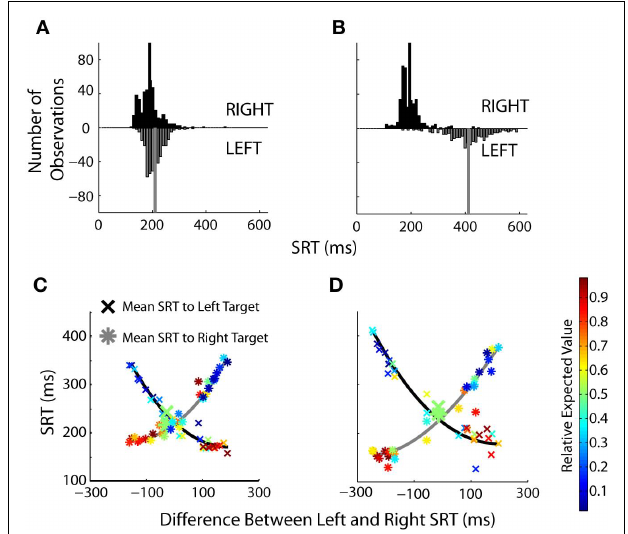
FIGURE 6 |The influence of value on SRT distributions. (A,B) Histograms for equal value (50% left probability/50% left reward magnitude) and skewed value (10% left probability/38% left reward magnitude) blocks of trials. Black bars represent SRTs to the right target, gray bars represent SRTs to the left target.The mean of each distribution is indicated by the solid vertical lines. (C,D) Same single-target data set as Figures 4C,D . Each data point represents one of the 49 different prospects, composed of 150–225 individual trials collapsed over two to three blocks of the same prospect. Blocks are not sorted on value, but on the difference in SRTs between the left and right targets. Enlarged points are blocks in which the value was equal to the left and right targets.The relative expected value of each point is indicated by the heat map legend on the right.